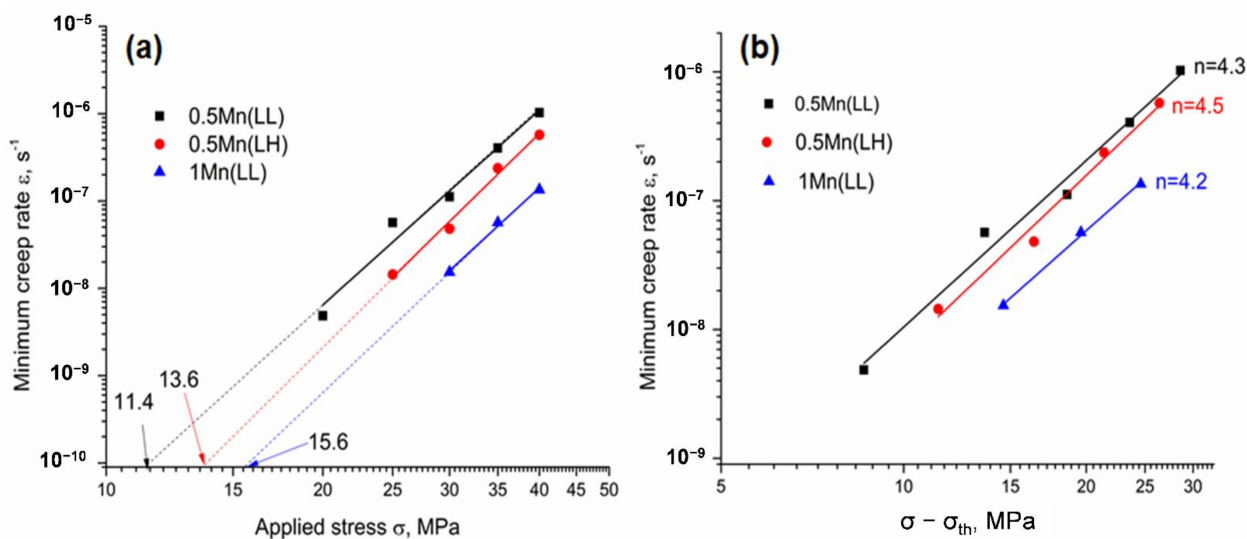
Figure 9. Determination of threshold stress σ th in the plots of the minimum creep strain rates vs. applied stresses ( a ) and the true stress exponent n in the plots of the minimum creep strain rates vs. the effective stresses ( b